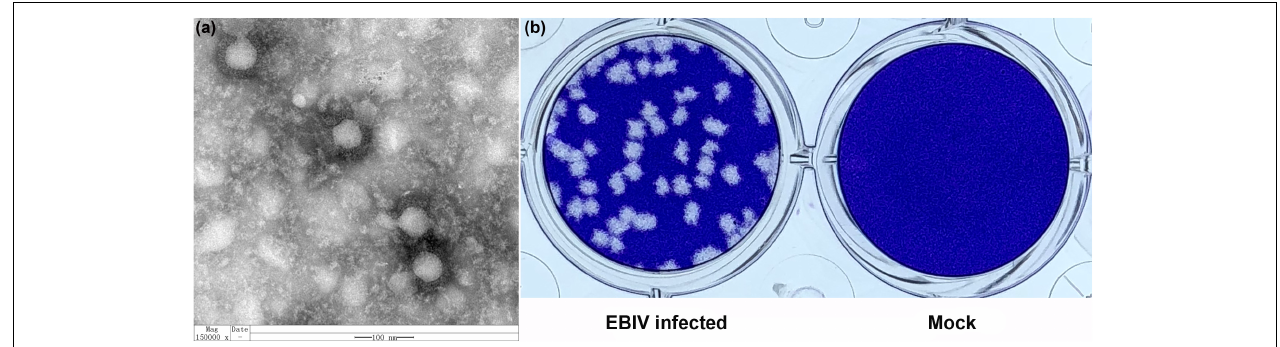
FIGURE 3 | The morphology and viral plaque in cells. (a) Negative-stained ultracentrifuged virions of EBIV. (b) Crystal violet-stained BHK-21 cell monolayers showing plaques generated by EBIV at 72 h postinfection.